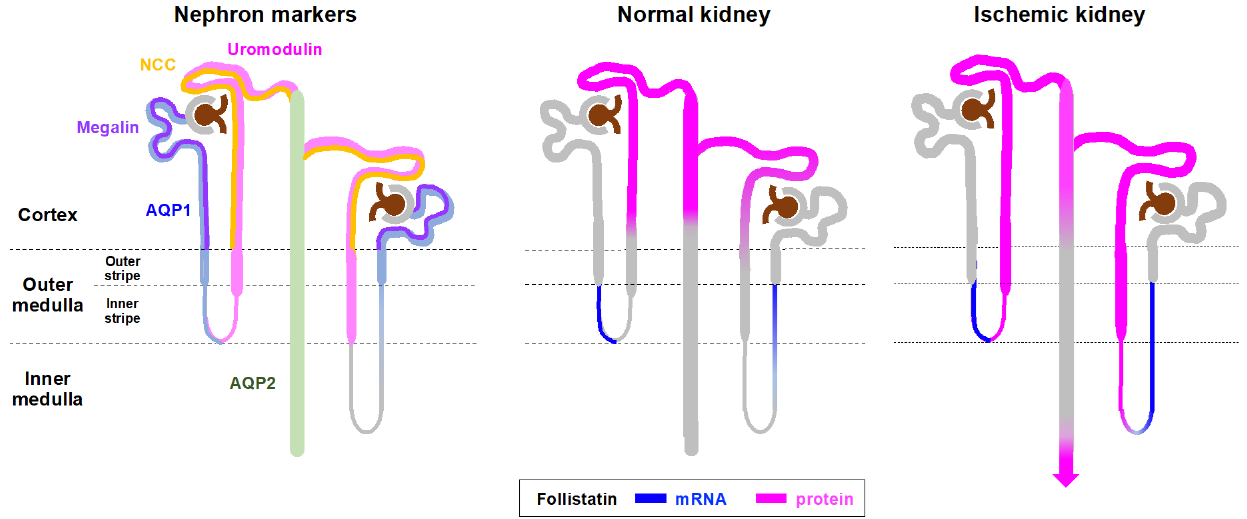
Figure 6. Possible mechanism of follistatin excretion into urine after renal ischemia. Aquaporin 1, AQP1; aquaporin 2, AQP2; Na-Cl co-transporter,